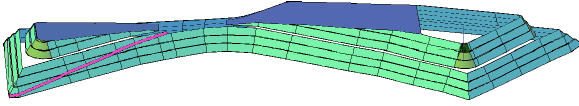
Figure 8: Virtual 3D model of the solid waste landfill – axonometric view (source: the authors’ own edition )